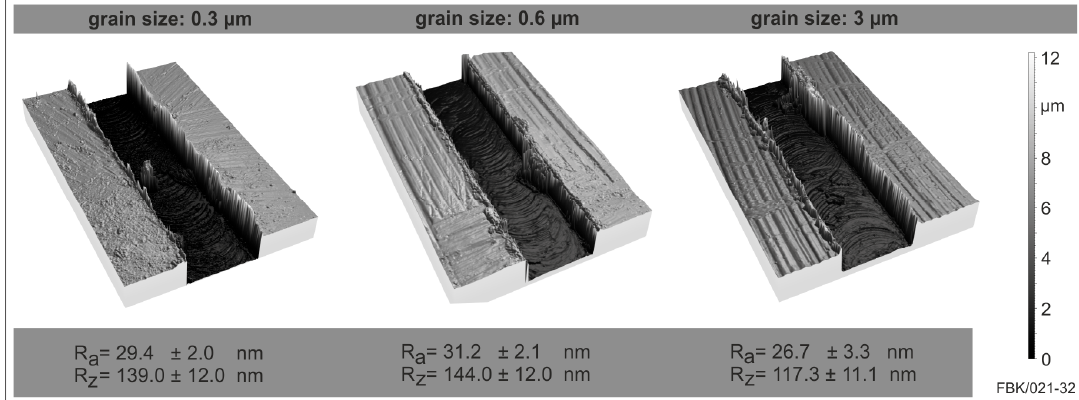
Figure 14. Bottom surface roughness in dependence of the cemented carbide grain size (from left to right: 0.3 µm, 0.6 µm and 3 µm).